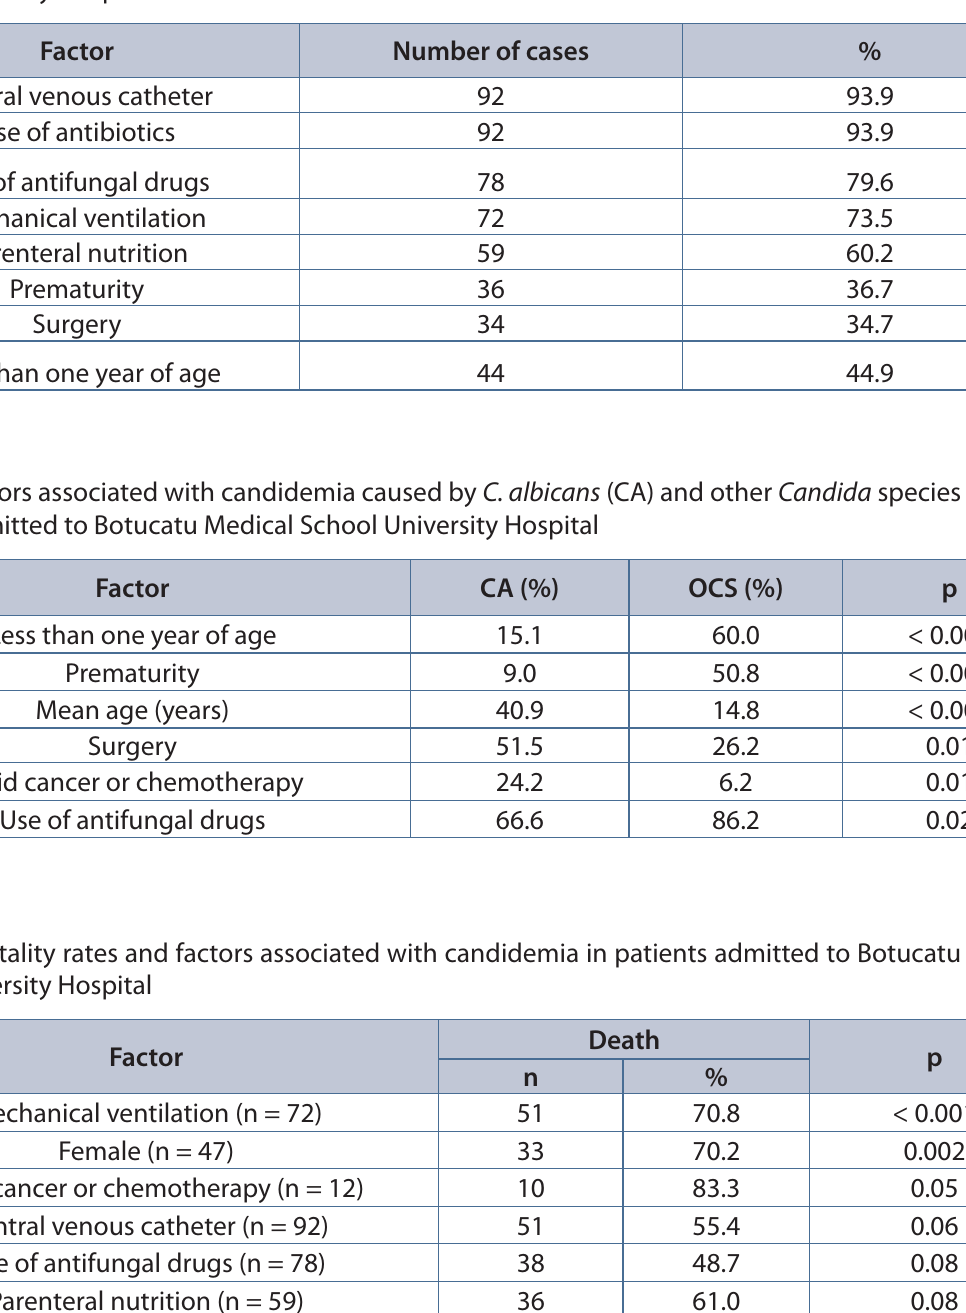
Table 4. Main factors associated with candidemia development in patients admitted to Botucatu Medical